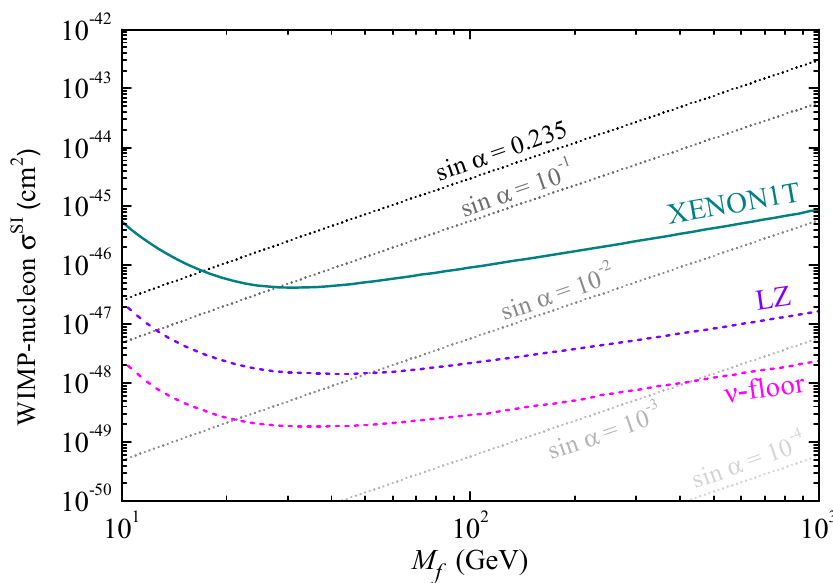
Figure 16 . Spin-independent WIMP-nucleon cross section σ SI as a function of the fermion DM mass M , for different values of sin α . The maximum value | sin α | ’ 0 . 235 corresponds to the f experimental limit for m = 450 GeV [149, 150]. The presented DD experimental bounds are the h 2 same as those in figure